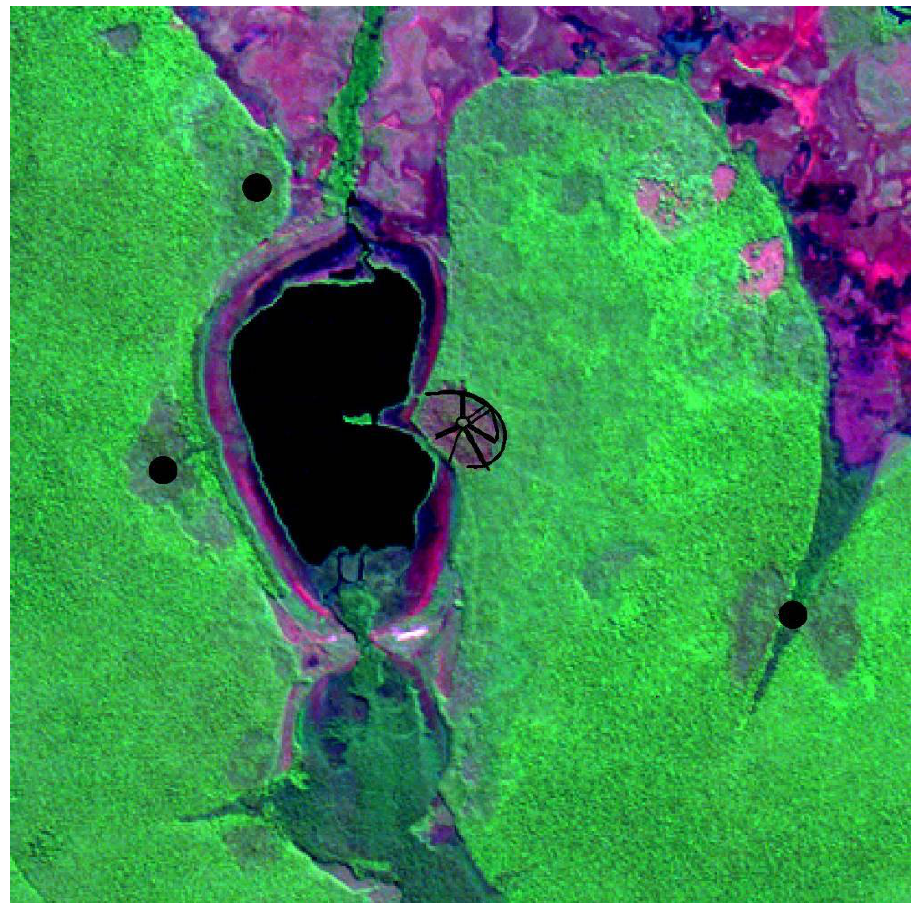
Figure 3. Core area of southern cluster showing principal center (X11), showing peripheral semi-circular ditches and radial roads, and primary satellite settlements, marked as black dots (note: vegetation ―scars‖ associated with major